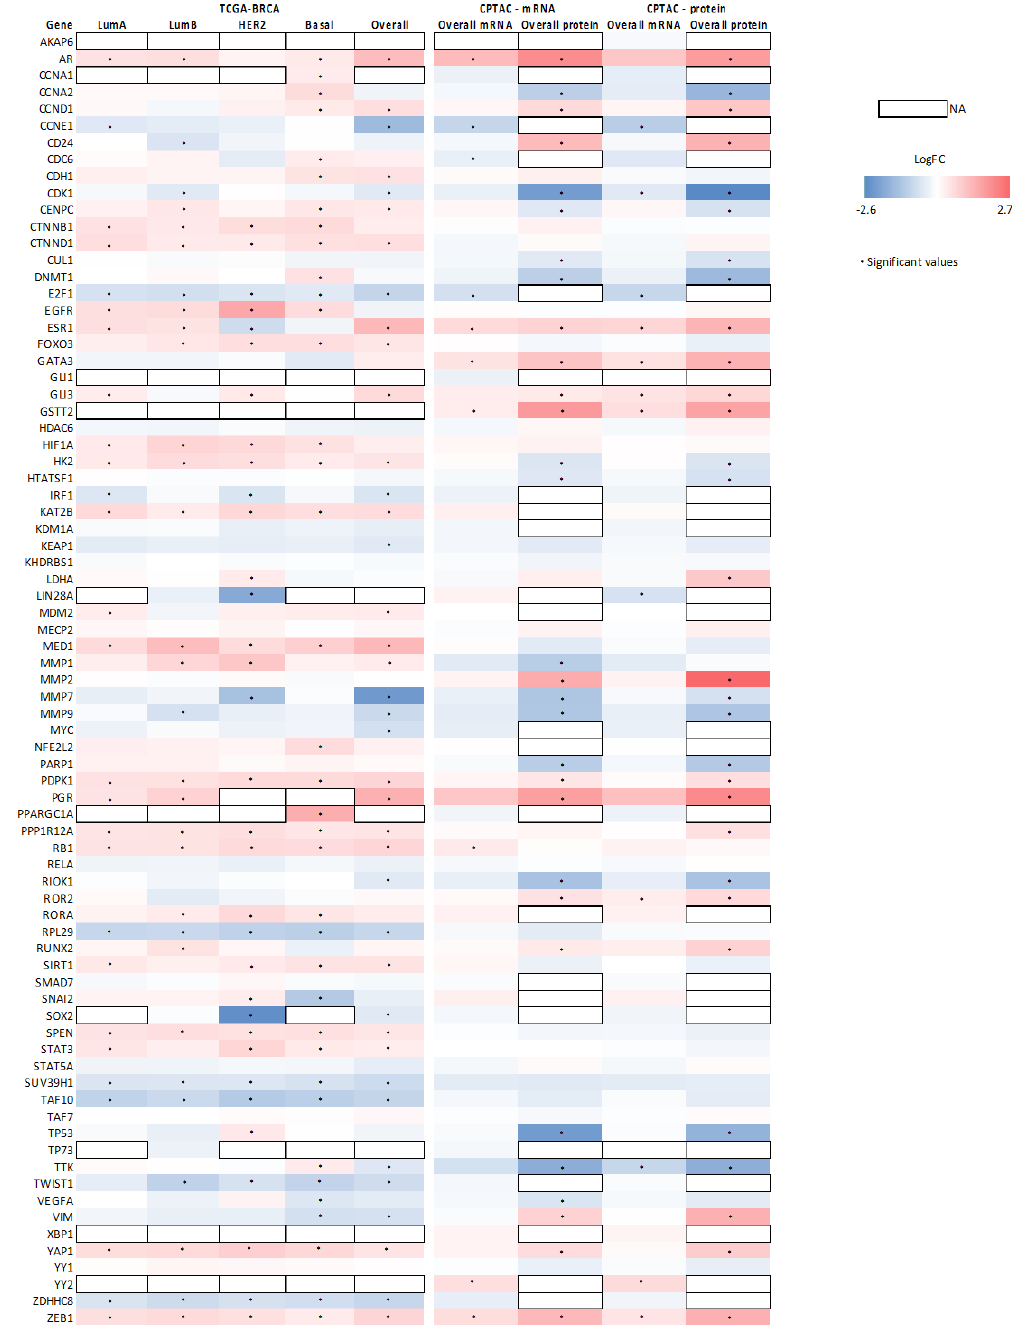
Figure 5. Heatmap showing the association of several genes of interest, including known SETD7 targets, with SETD7 differential expression using the TCGA-BRCA dataset (analysis performed both by subtype and by pooling all BC samples—overall) and CPTAC dataset (SETD7 stratified by mRNA or protein; analysis performed by pooling all BC—overall). Genes enriched in low-SETD7 group have negative log2 fold change (blue) and the ones enriched in the high-SETD7 group have positive log2 fold change (red). Genes with a significant adjusted p -value (Bonferroni post hoc, <0.05) have a star. Genes that were not present for a particular condition are represented as not available (NA, white boxes). Some genes were not detected in any dataset and were excluded from the figure: ATOH1 , ESR2 ( ERβ ) , GATA1 , NANOG , NR1H4 (FXR), and PDX1 .